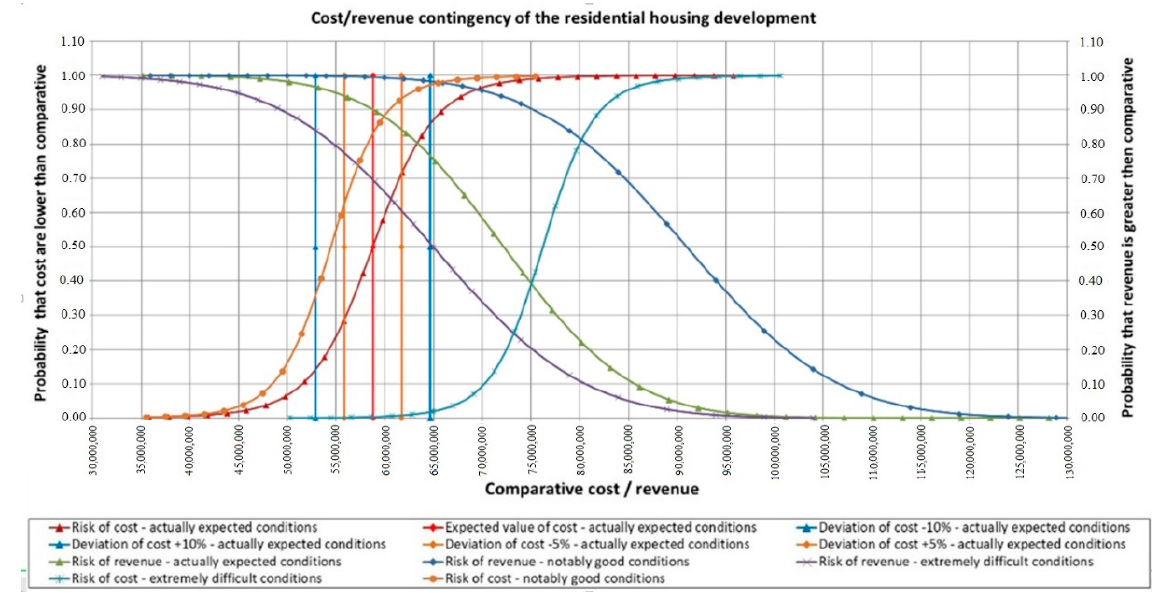
Figure 2. Comparative risk characterization of the costs and revenues of the residential housing development 2.